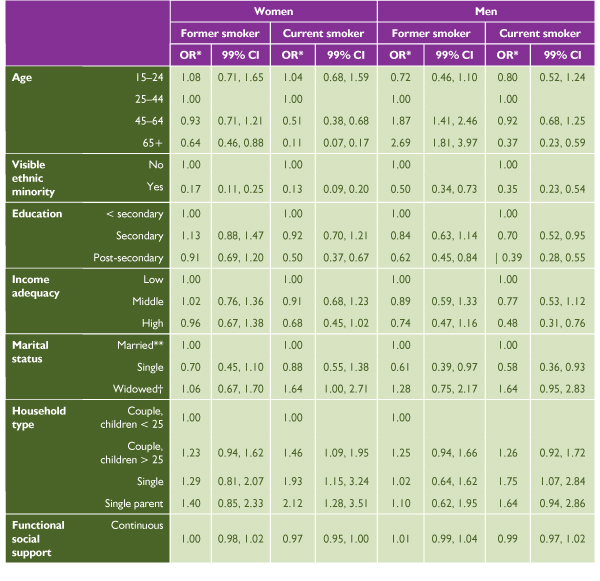
Multivariate Association Between Socio-demographic Factors and Smoking Status (Former and Current Smoking Compared with Never Smoking), by Sex (NPHS 1998–1999).*OR = odds ratio;   **Married/common law/partner  †Widowed/separated/divorced